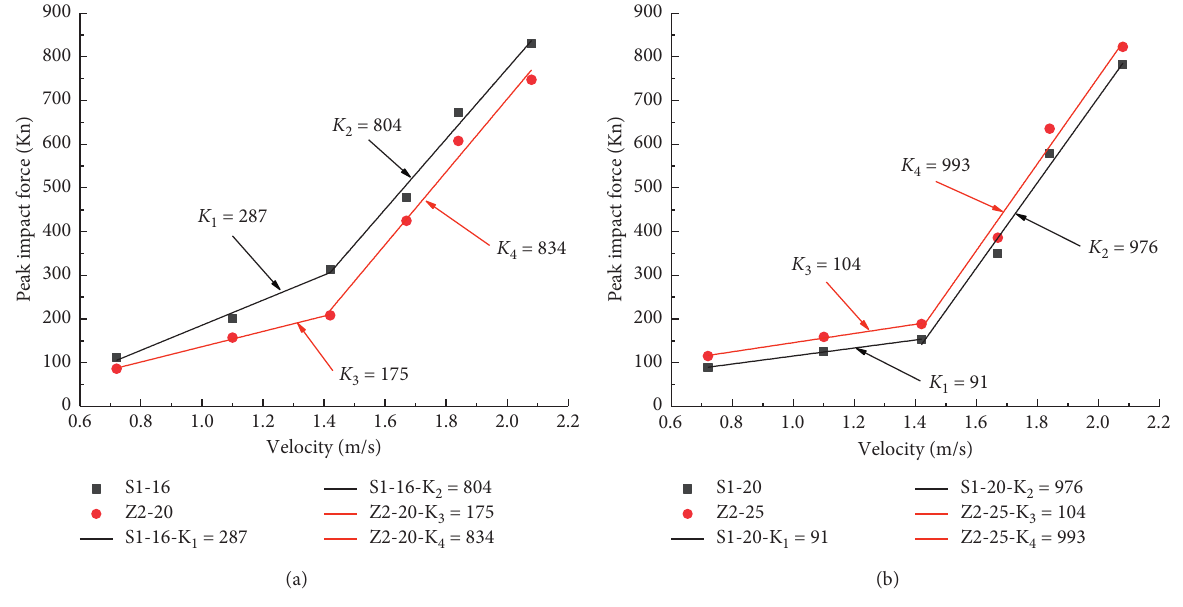
Figure 11: Peak impact force of the first and second